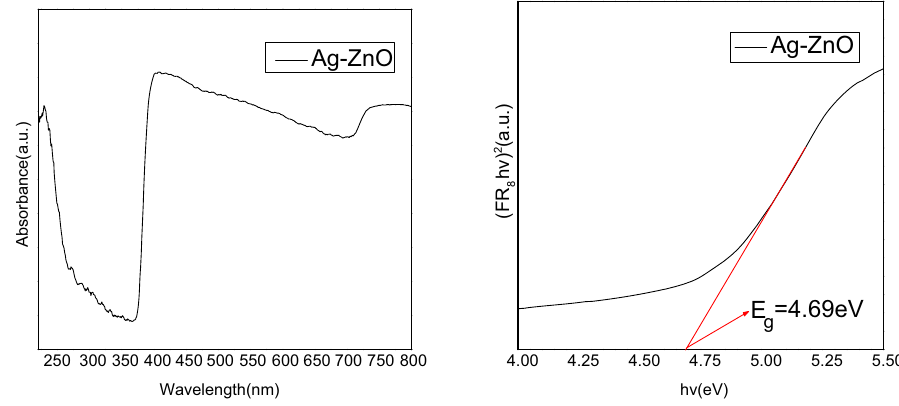
Figure 7: UV - Vis di ff use re fl ection spectroscopy and band gap width of Ag/ZnO.